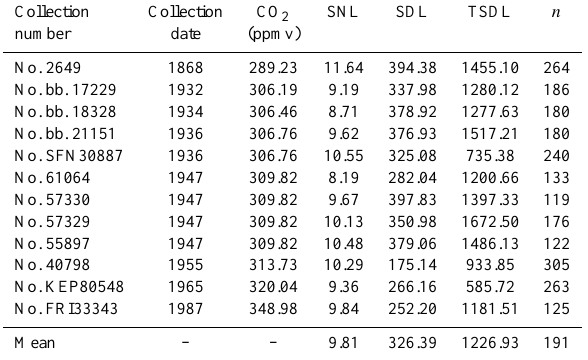
Table 5. Summary of stomatal parameters from modern Nageia motleyi (Parl.) De Laub. (Kouwenberg et al., 2003).